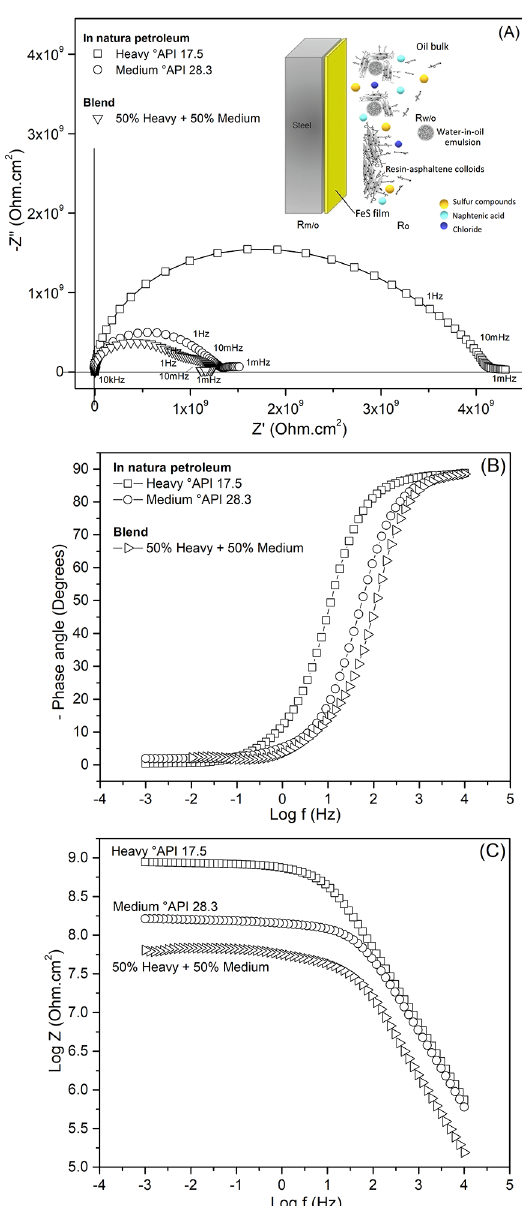
Figure 1. Nyquist diagram (A) and Bode diagram: phase angle (B) and impedance module (C). Potential amplitude of ± 350 mV, frequency interval 10.0 kHz - 1.0 mHz.